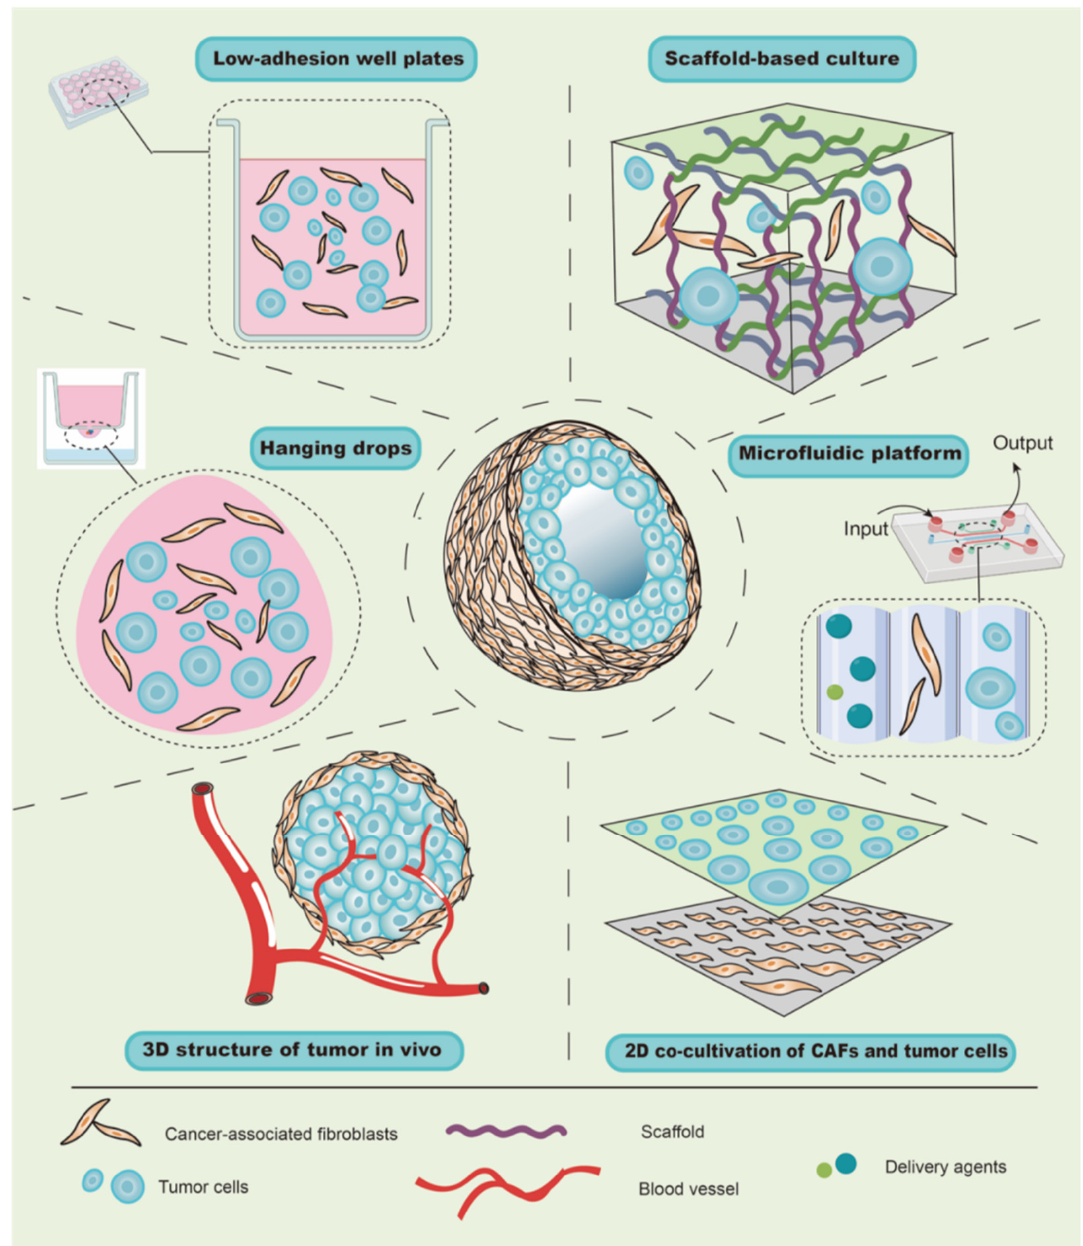
Figure 2. Co-culture models of CAFs and tumor cells. Tumors in vivo have a complex structure, where the tumor cells and CAFs crosstalk with each other in 3D structure. The tumor cells or CAFs in traditional co-cultured model grow in 2D space. The usage of hanging drops aims to form tumor spheroids. Cell suspension flows out from the small holes of the upper container and forms hanging drops under the action of surface tension, and then the cells inside gradually form spheres under the action of the tumor. The liquid in the lower container is performed to compensate for the evaporation of water in the hanging drops. Using the low-adhesion well plates, which make cells unable to adhere to the wall, the suspended cells aggregate into visible spheroids. Various scaffold materials form complex 3D structures for cell culture by providing space. The gel containing tumor cells/CAFs is poured into the channels etched on carrier, and combined with the perfusion system. The cells in the channels can grow under the fluid pressure, thereby simulating the interstitial fluid flow of the